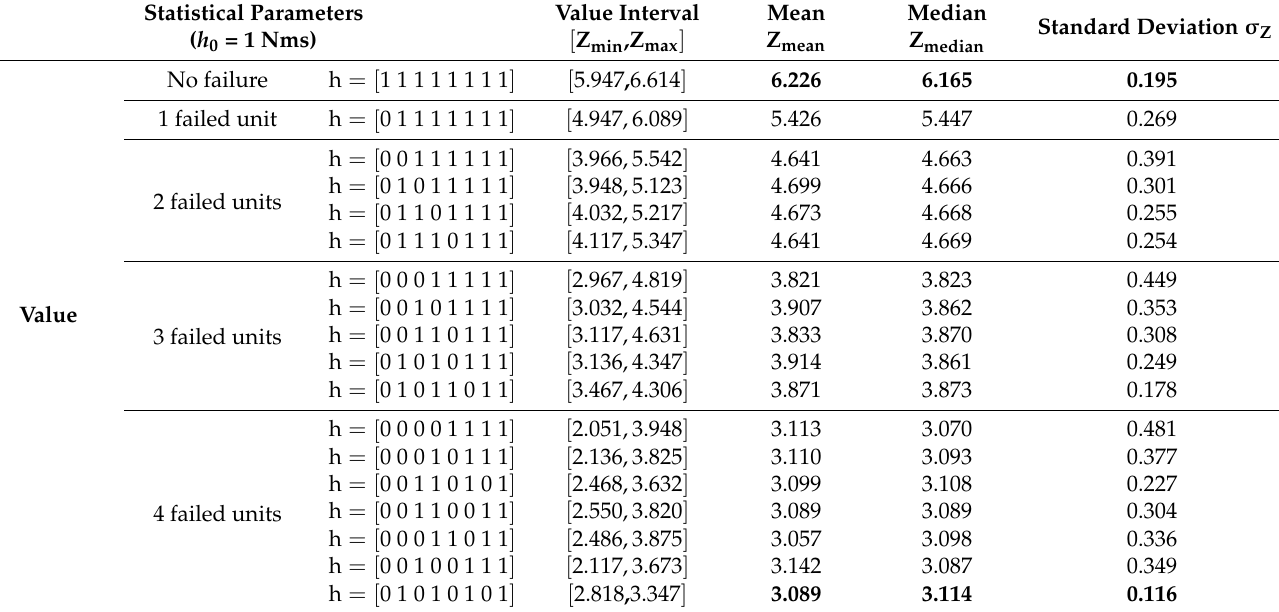
Table 1. Statistic of momentum and failure momentum envelops of 8−SGCMGs.